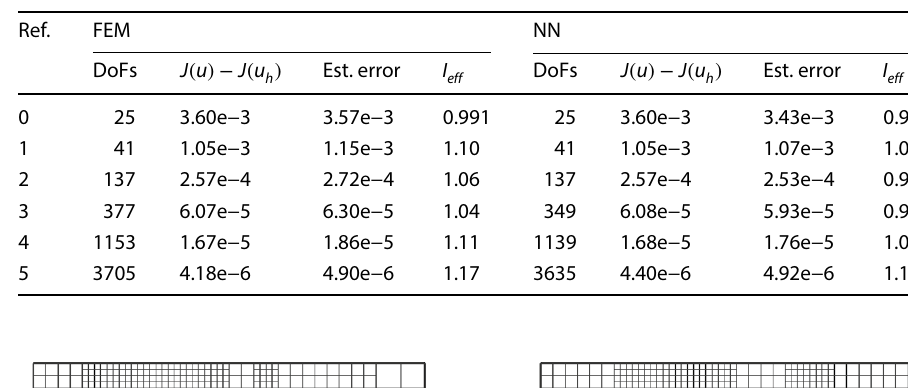
Fig. 2 Section 5.1.2: Grid refinement with regional mean value goal